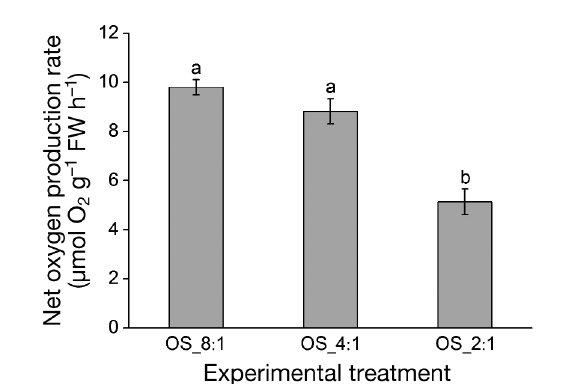
Fig. 7. Net oxygen production rates of seaweed Gracilaria lemaneiformis in oyster Crassostrea angulata −seaweed co- culture mesocosms (see Table 1 for treatments). Bars with different lowercase letters are significantly different (ANOVA, p <